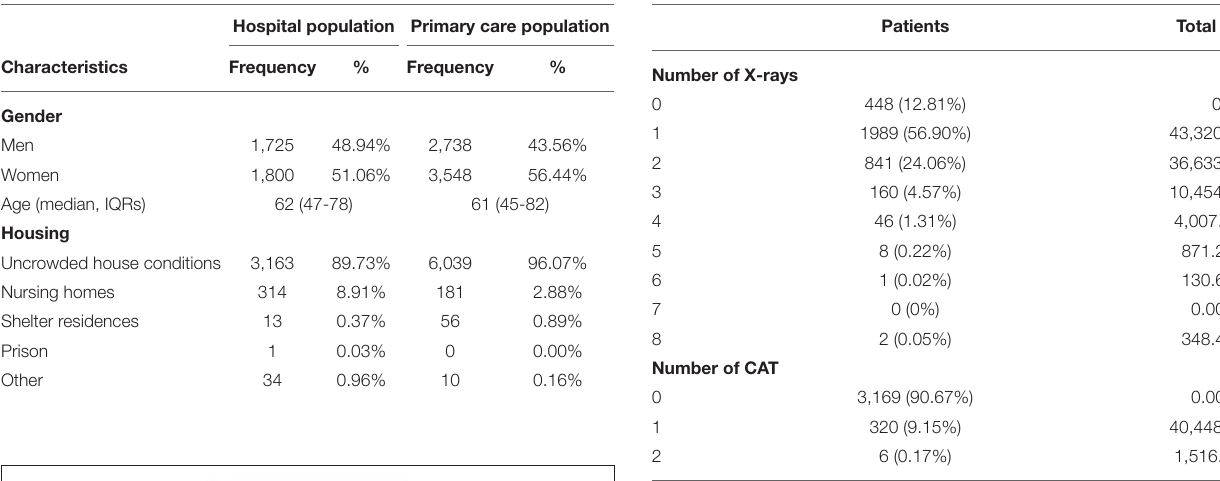
TABLE 2 | Cost of diagnostic imaging.